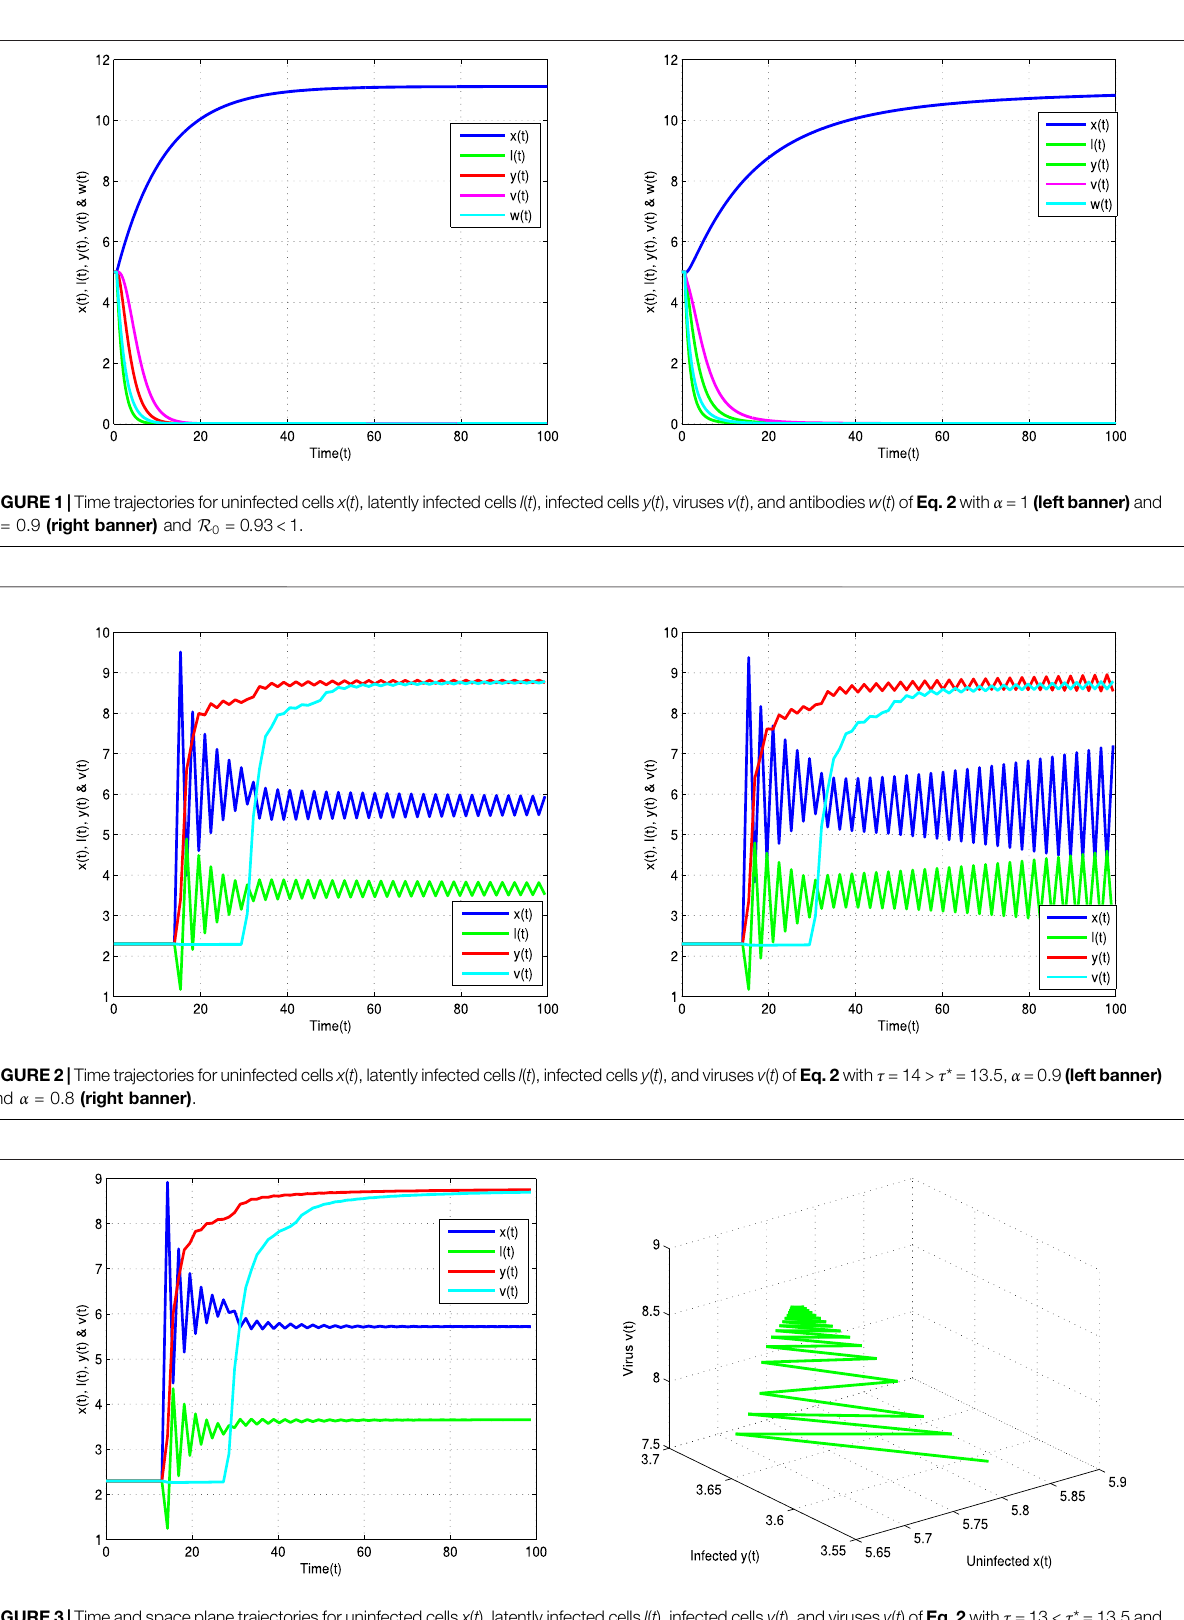
Frontiers in Applied Mathematics and Statistics |